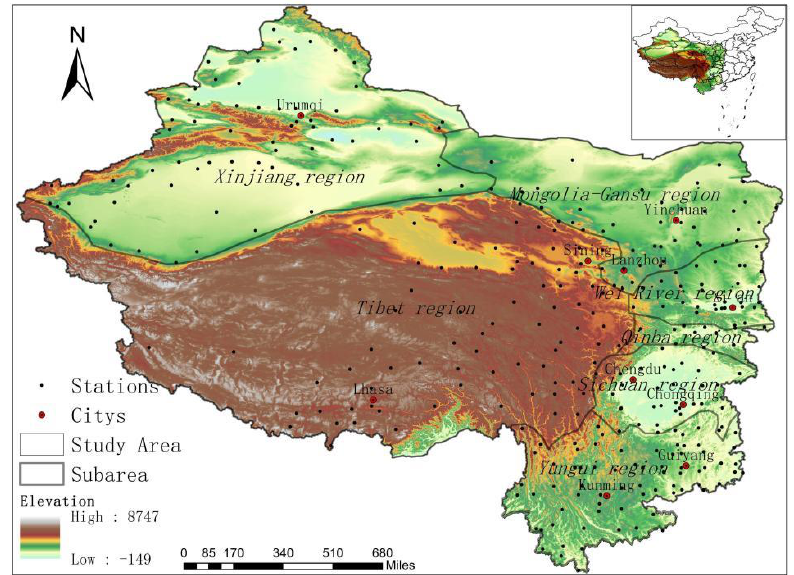
Figure 1. Study area with the position of weather